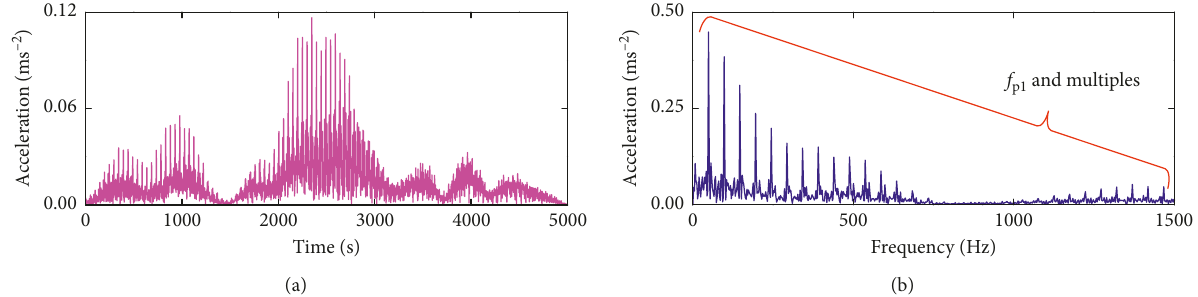
Figure 13: (a) Fourier spectra of the extracted IRS; (b) Hilbert envelope spectra of the extracted IRS. fb-kurt.2-K = 1.1 @ level 3.5, Bw = 416.6667Hz, f max